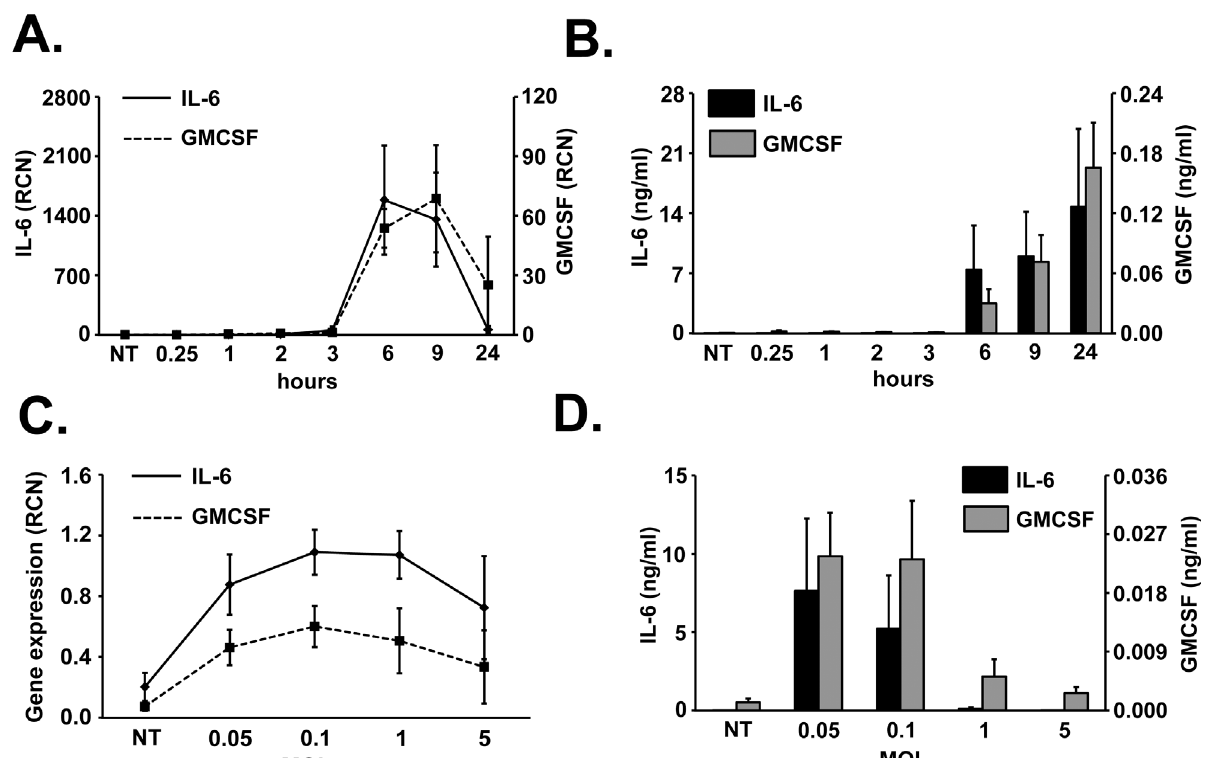
Fig 3. Cytokine kinetics in monocytes in response to D39. Human monocytes (10 6 cells/ml) (A, B) were infected with D39 at an MOI of 0.1 for different time periods through 24 h or were infected with different MOIs of D39 for (C) 3 h or (D) 6 h. Cell extracts were analyzed for (A, C) mRNA expression using qPCR or (B, D) cytokine release using ELISA. The graphs represent the mean ± SEM of 3 independent experiments. NT stands for not treated.